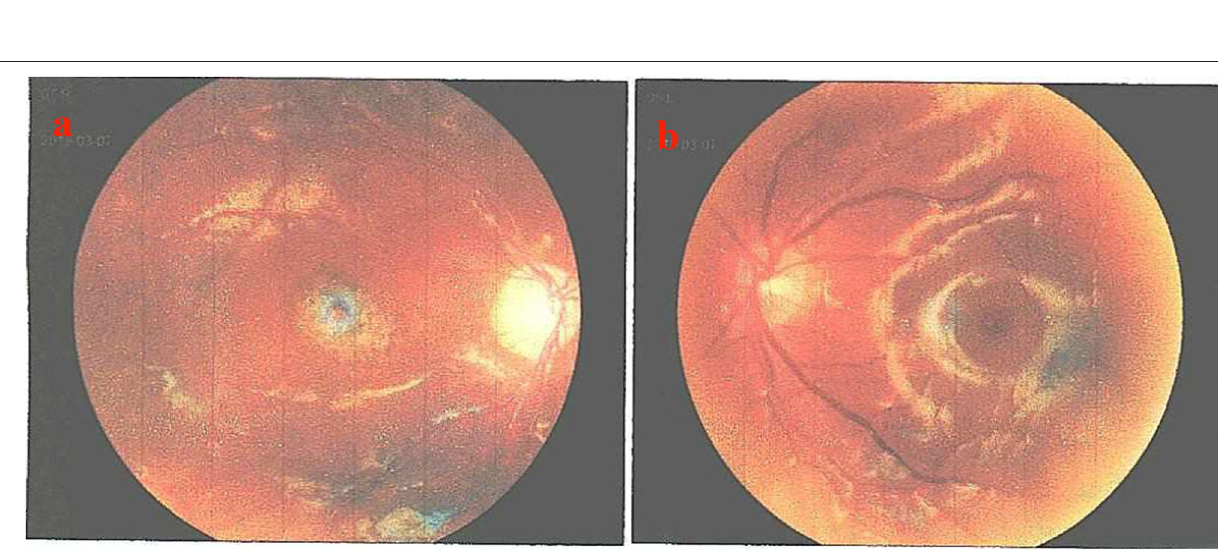
FIGURE 3 | Ocular fundus changes in the patient. (a) No obvious abnormality was observed in the left fundus. (b) The cornea of the right eye was deformed, the anterior chamber was clear, the crystal membrane was white and cloudy, the intraocular lens was normal, the optic papilla was pale, and the macular area was yellow and disordered (C/D =